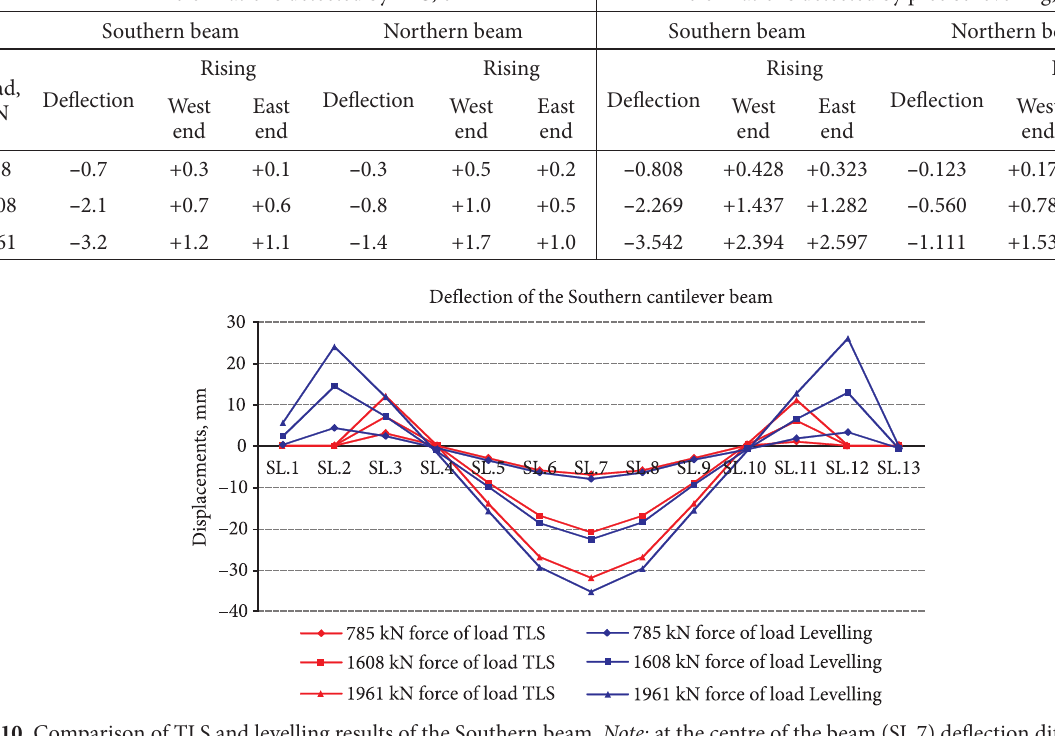
Fig. 9. Results from the loading of 1961 kN force Table 2. Deformations determined by precise levelling and TLS Deformations detected by TLS, cm Deformations detected by precise levelling, cm